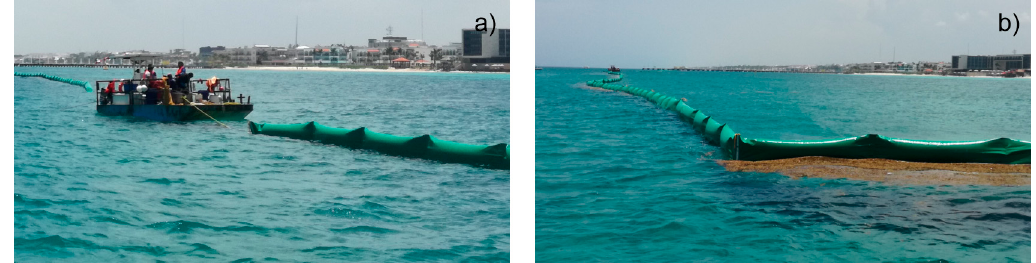
Figure 13. U-shaped barriers to contain sargasso off in Playa del Carmen. ( a ) Frontal view, ( b ) lateral view.